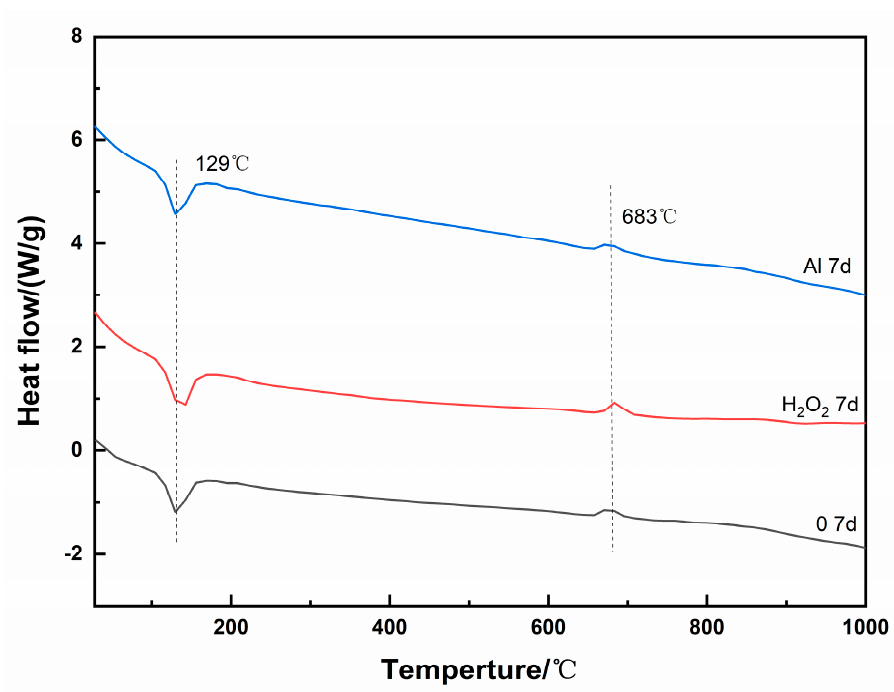
Figure 10. DSC of HMNS-FA-phosphate-based porous geopolymers.